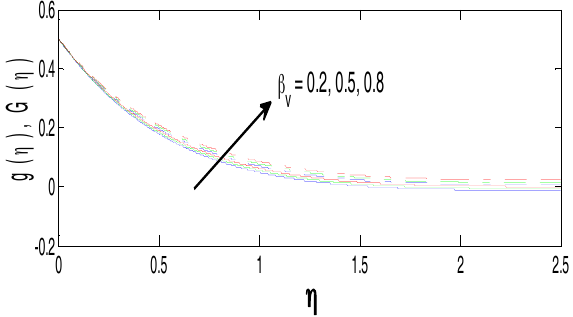
Figure 7. Impact of β υ on lateral velocity profile g and G of fluid with dusty Figure 7. Impact of 𝛽 (cid:3100) on lateral velocity profile g and G of fluid with dusty particles. Figure 7. Impact of 𝛽 (cid:3100) on lateral velocity profile g and G of fluid with dusty particles. Figure 7. Impact of 𝛽 (cid:3100) on lateral velocity profile g and G of fluid with dusty particles. Figure 7. Impact of 𝛽 (cid:3100) on lateral velocity profile g and G of fluid with dusty particles.